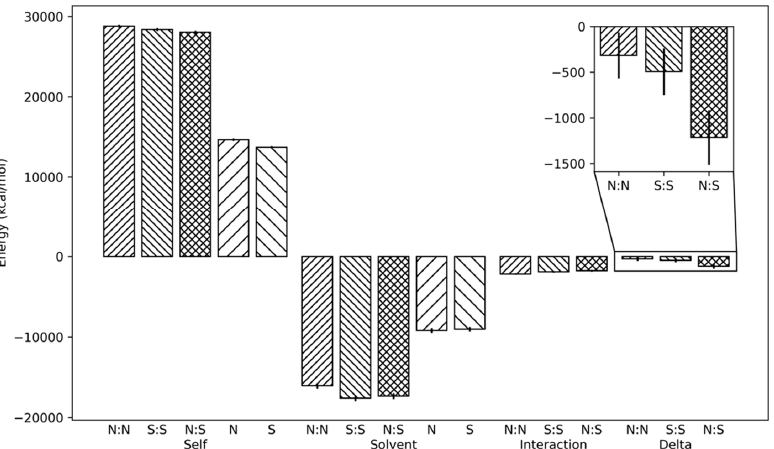
Figure 3. The NONO::SFPQ heterodimer formation is thermodynamically favored, when compared to NONO and SFPQ homodimers. Decomposition of interaction energies: protein internal energy, protein::solvent interaction, protein::protein interaction. Zoomed pane is dimer formation energy. Energy values are averaged over the stable last 50% of MD trajectories, error bars represent the standard deviation.